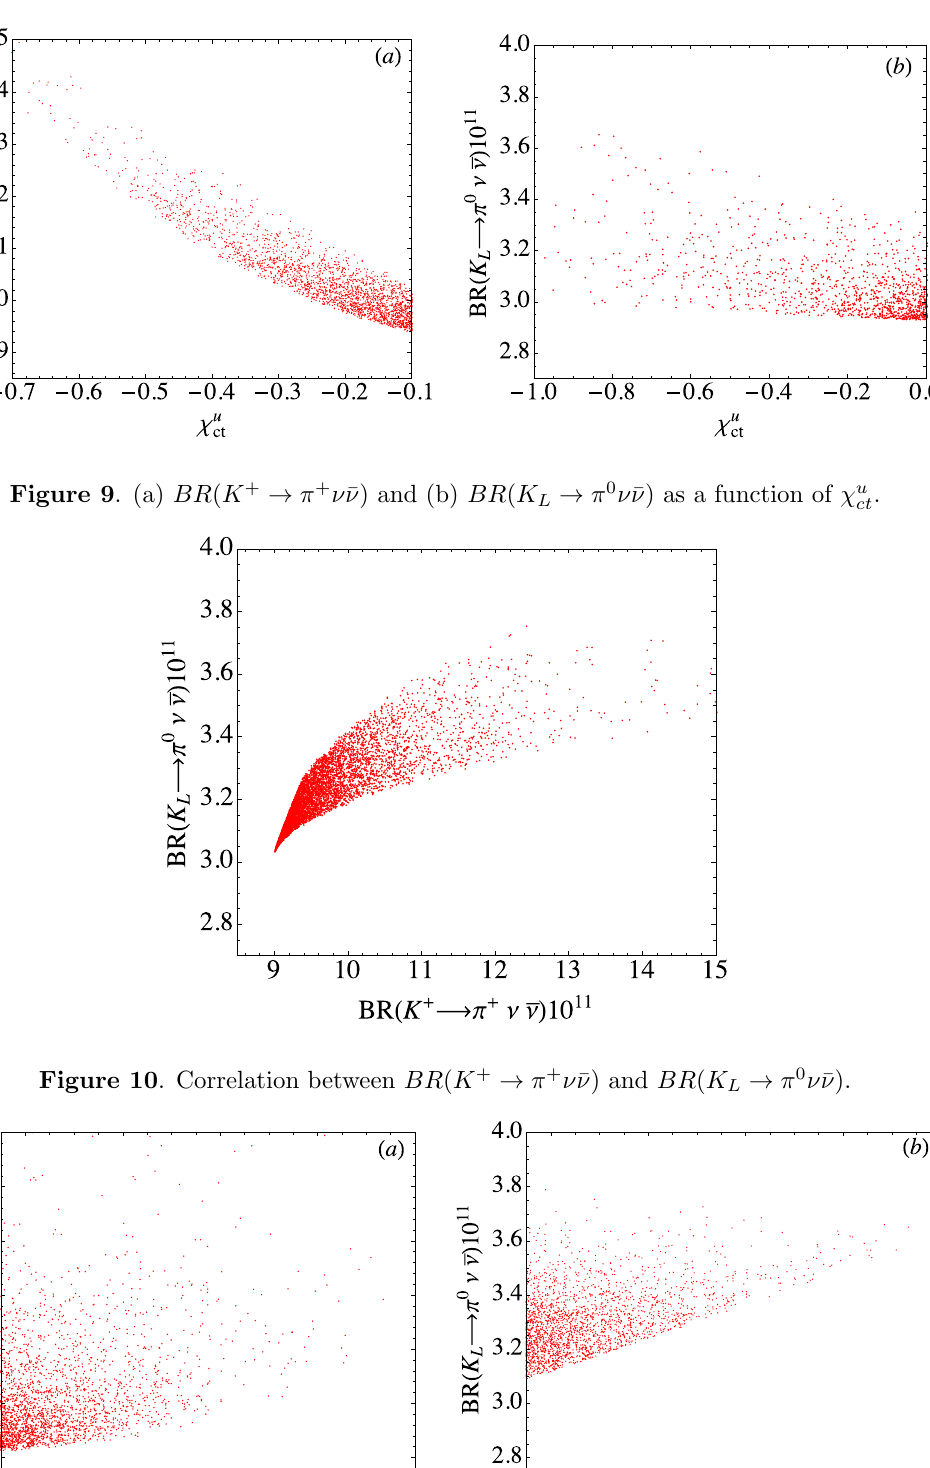
Figure 11 . Correlation between ( (cid:15) 0